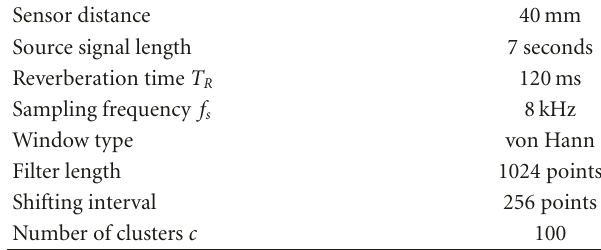
Figure 6: Smooth slope. Table 1: Experimental